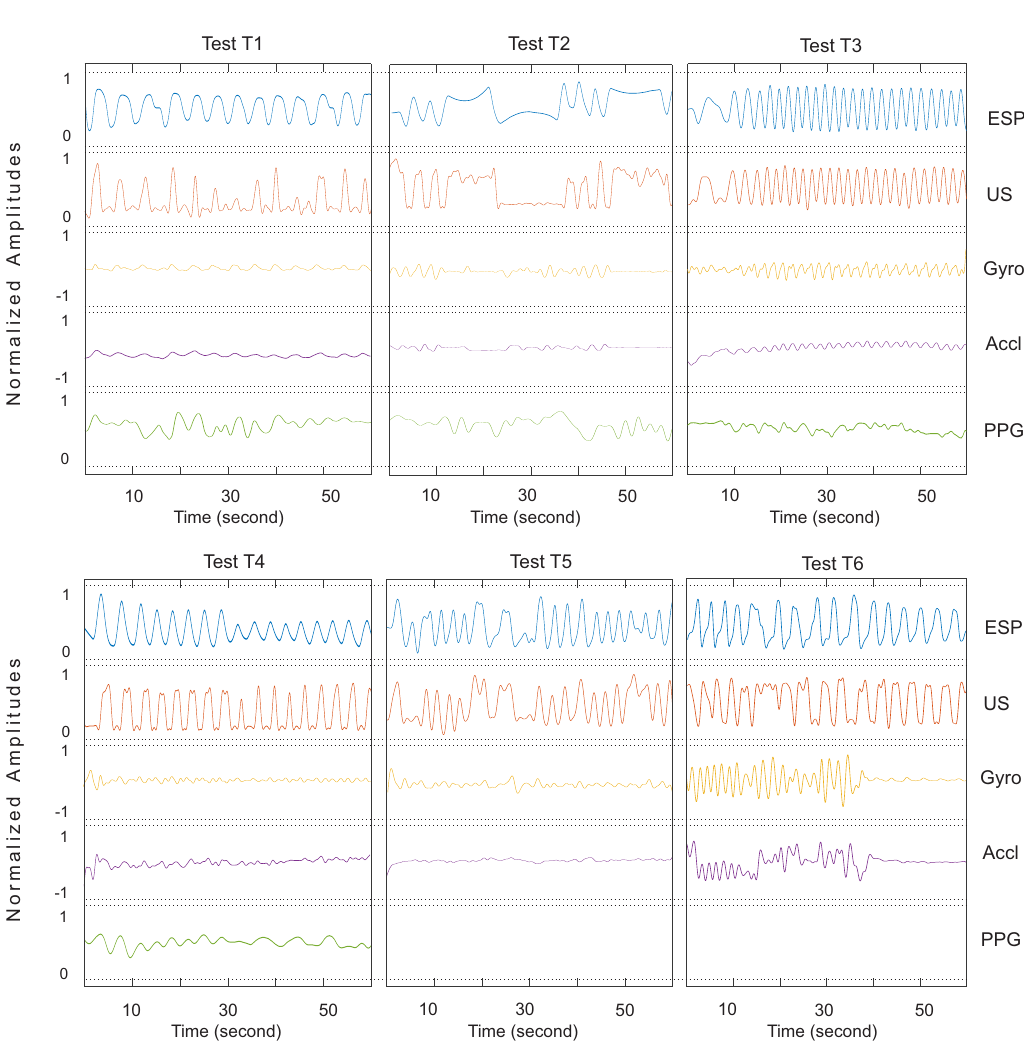
Figure A5. Respiratory waveforms of Subject